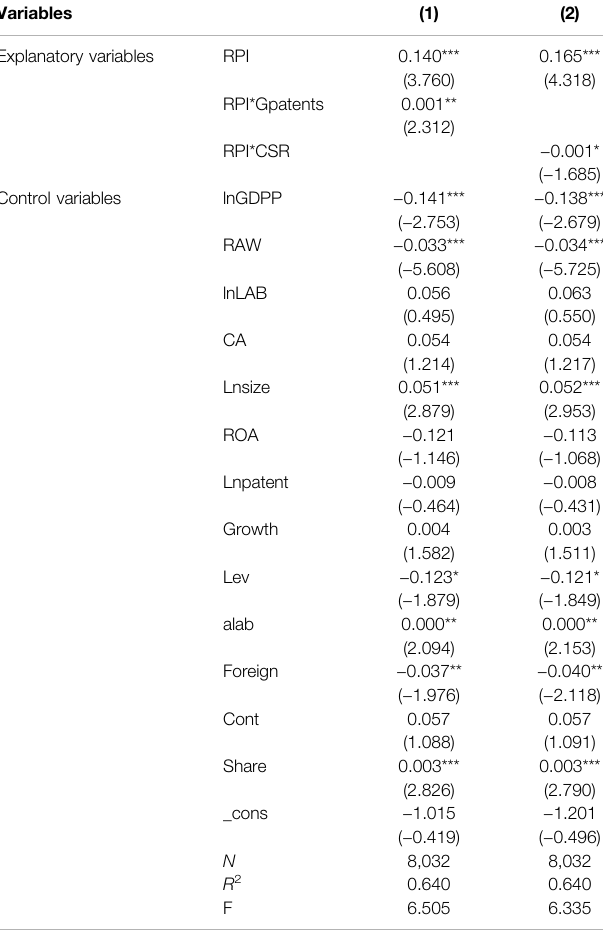
TABLE 8 | Results of baseline regression. TABLE 9 | Results of moderating variables